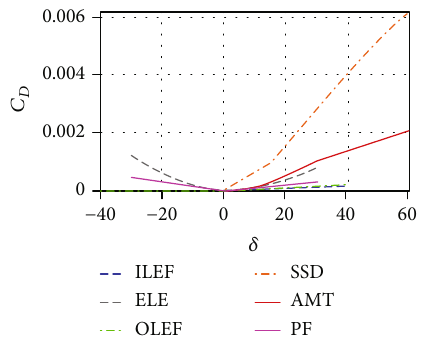
Figure 5: Control surface drag e ff ectiveness curve of tailless